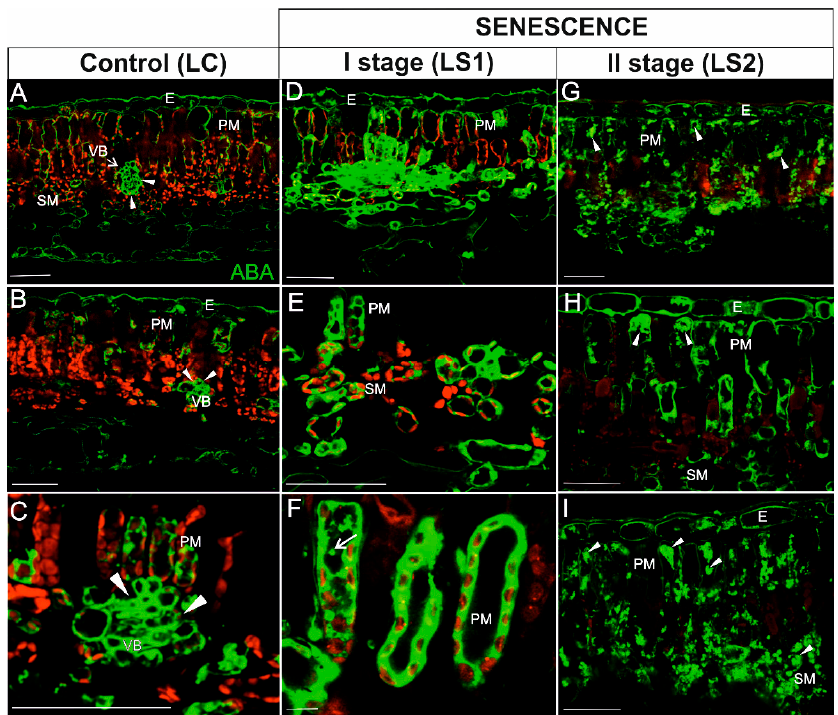
Figure 8. Immunodetection of ABA (green fluorescence) and red autofluorescence of chlorophyll during leaf senescence. ( A – C ) Leaves control (LC); ( D – F ) The first stage of leaf senescence (LS1); ( G – I ), The second stage of leaf senescence (LS2). Abbreviations: VB, vascular bundle; PM, palisade mesophyll; SM, spongy mesophyll; E – epidermis. Scale bars = 50 µm.